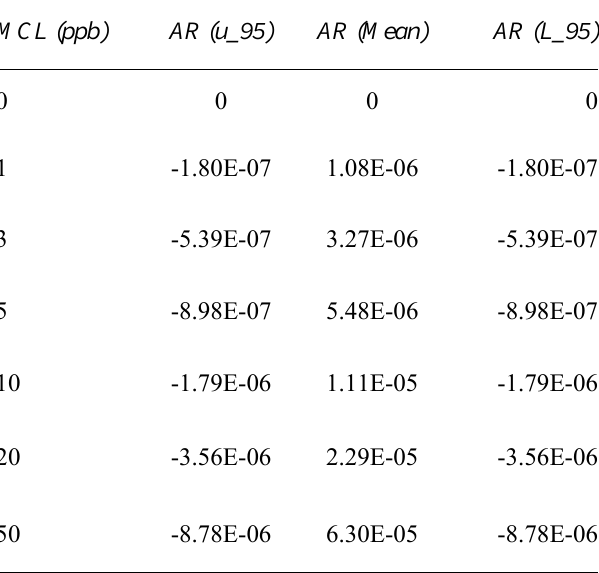
Table 1: Risk of bladder cancer at different